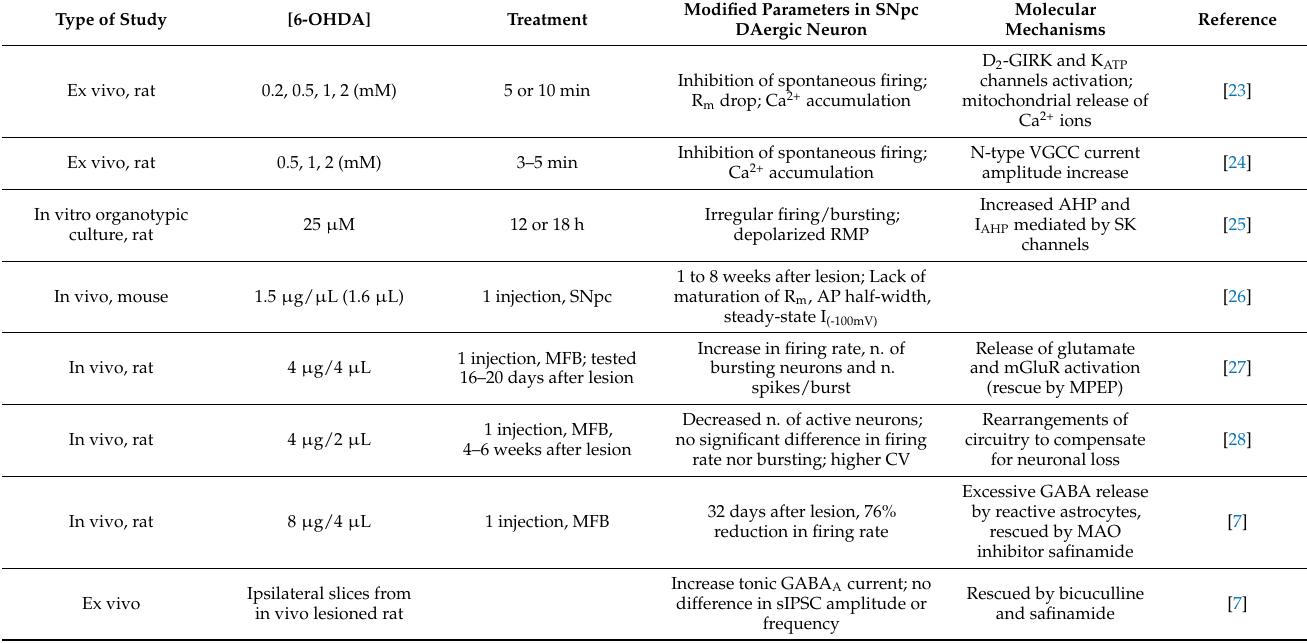
Table 1. Summary of the principal findings of the cited literature on 6-OHDA effects on SNpc DAergic neuron functional